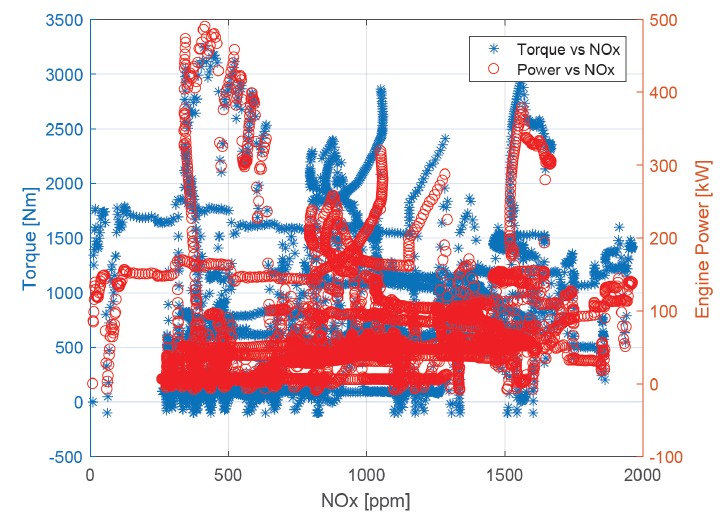
Figure 9. Nitrogen oxide (NOx) emissions compared against power and torque.